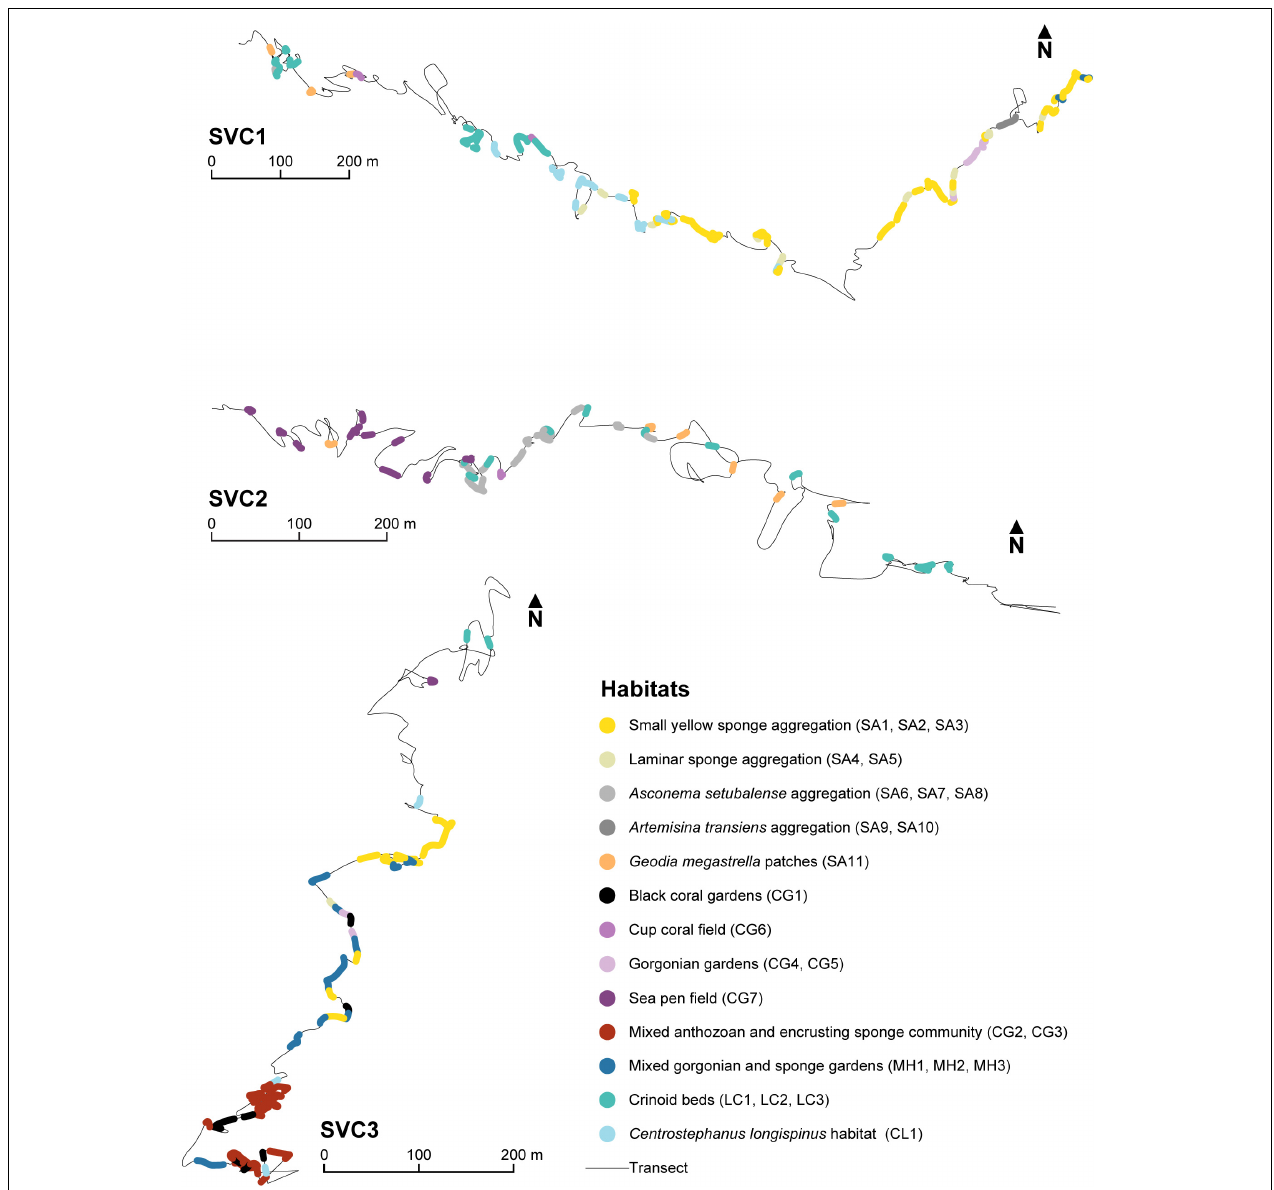
FIGURE 5 | Habitat distribution maps of the 13 potential priority habitats, representing the 25 assemblages (IDs in parenthesis) within each study transect (SVC1, SVC2 and SVC3). Habitats are mapped with different colors as specified in the legend.